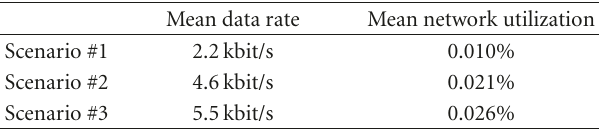
Figure 8: Details about the number of HELLO and TC messages created in the three di ff erent scenarios, along with the actual number of OLSR packets injected into the network. Table 2: Data rate and network utilization for OLSR tra ffi c in di ff erent